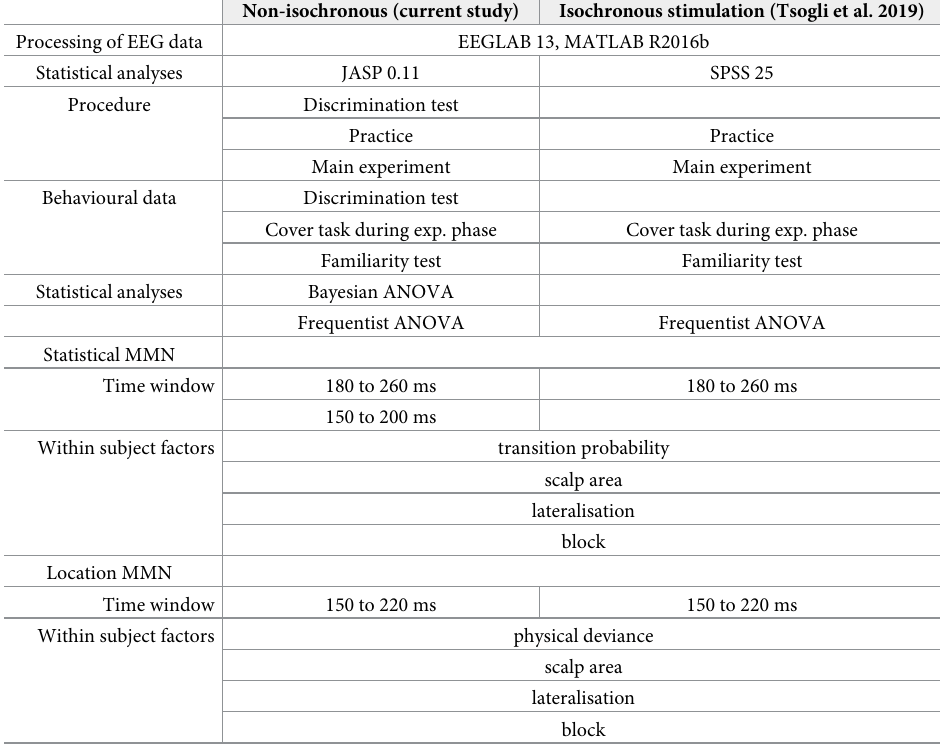
Table 4. Comparative view of methodological details for the two